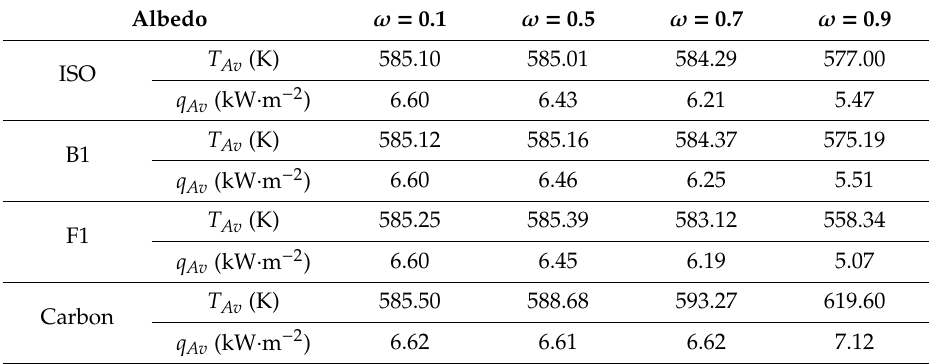
Figure 8. Effects of the absorption and albedo coefficients on the net radiation heat flux density Figure 8. E ff ects of the absorption and albedo coe ffi cients on the net radiation heat flux density distribution. Dashed lines: Isotropic, continuous lines: carbon. (a) case 7: ω = 0.1 ; κ = 1 m −1 , (b) distribution. Dashed lines: Isotropic, continuous lines: carbon. ( a ) case 7: ω = 0.1; κ = 1 m − 1 , ( b ) case 8: ω = 0.1; κ = 5 m − 1 , ( c) case 9: ω = 0.5; κ = 1 m − 1 , ( d ) case 10: ω = 0.5; κ = 5 m − 1 , ( e ) case 11: ω = 0.9; case 8: ω = 0.1 ; κ = 5 m −1 , (c) case 9: ω = 0.5 ; κ = 1 m− 1 , (d) case 10: ω = 0.5 ; κ = 5 m− 1 , (e) case κ = 1 m − 1 , ( f ) F1 function case 12: ω = 0.9; κ = 5 m − 1 , ( g ) isotropic case 12: ω = 0.9; κ = 5 m − 1 . Table 2. Average temperature and net radiation heat flux density value for di ff erent albedo values ( κ = 1 m − 1 ). Table 2. Average temperature and net radiation heat flux density value for different albedo values ( κ = 1m −1 ).